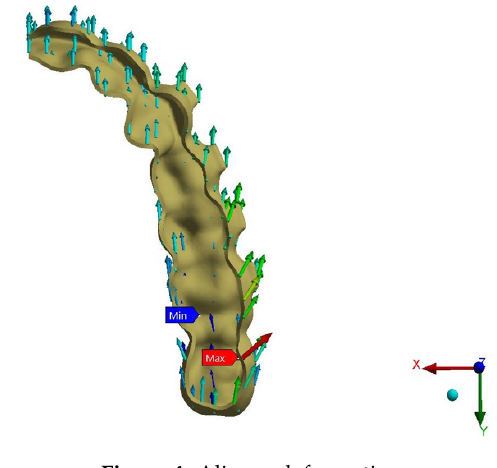
Figure 4. Aligner deformation.